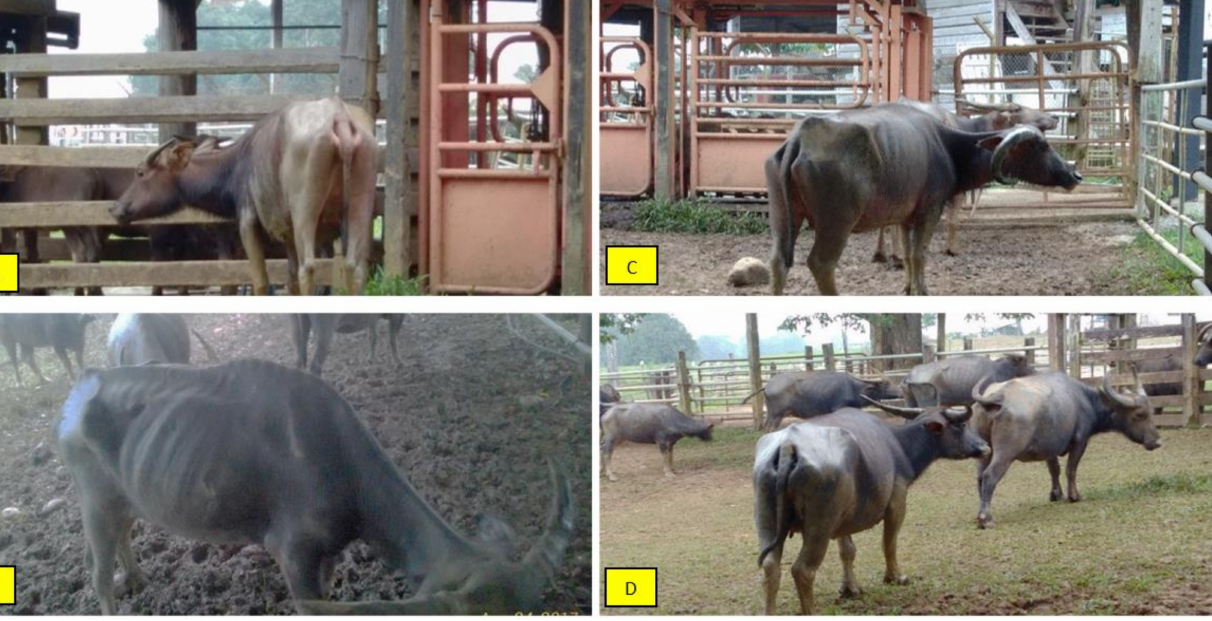
Figure 8. The body condition score of buffalo fed with and without supplemented diet. Notes: ( A ): after weaning calf (before feeding trials); ( B ): buffalo fed with Diet A; ( C ): buffalo fed with Diet B; ( D ): buffalo fed with Diet